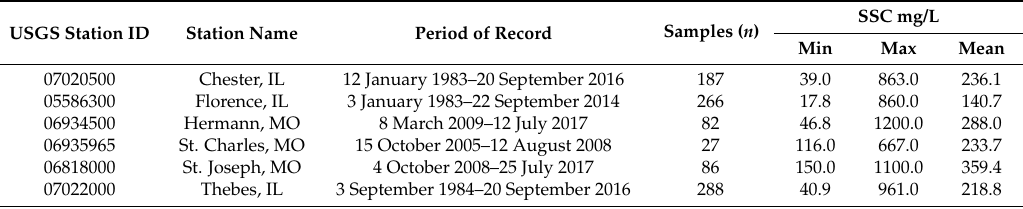
Table 2. Statistics of the filtered suspended sediment concentration (SSC) data corresponding to Landsat imagery.